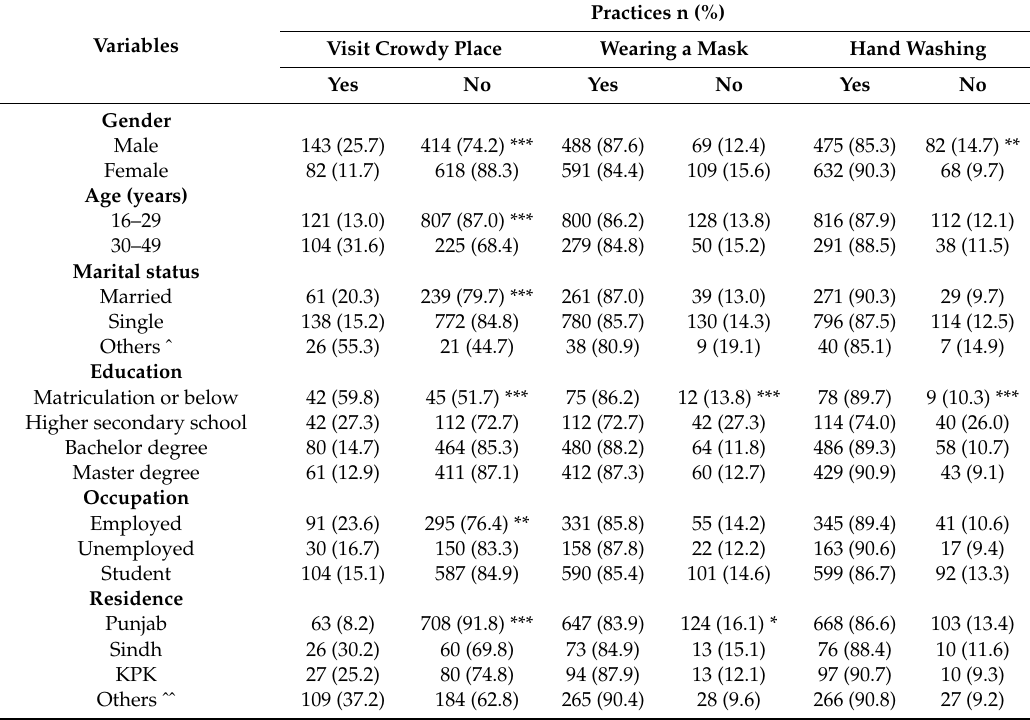
Table 5. Practices of the participants during the COVID-19 outbreak, by demographics.